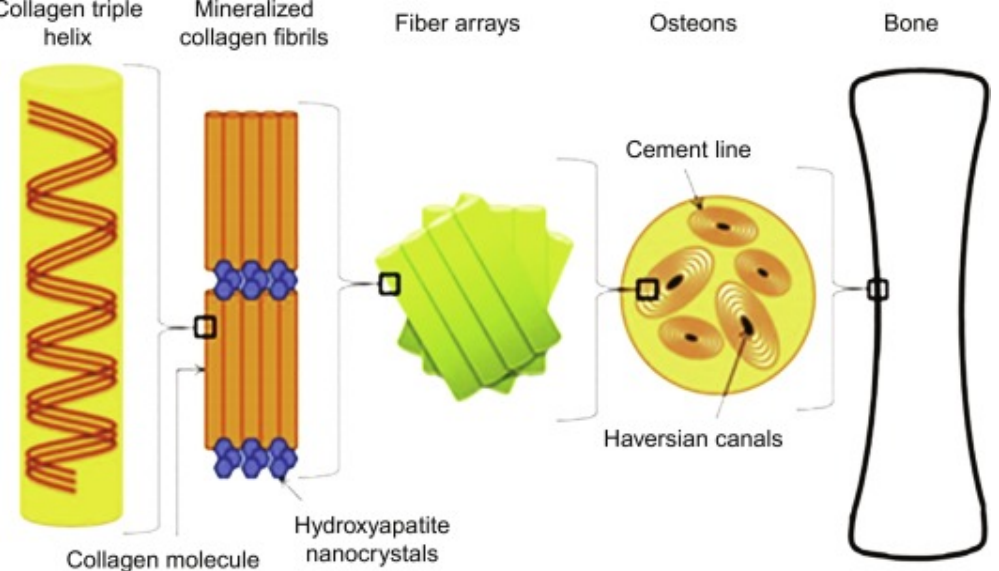
Figure 25. Schematic flow diagram indicating that hierarchical bone arrangement relies on the self-assembly of triple helices of collagen and the accumulation on the surface by HAp-precipitated crystals. The formation of structured and layered fibrous assemblies and osteons (i.e., concentric strands) corresponds to later measures. Reproduced with permission from [319].